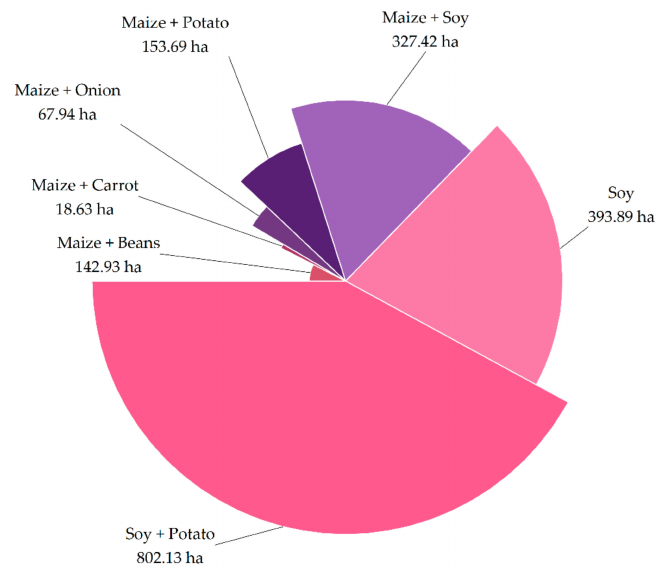
Figure 9. Crop area for each class in the 2015/2016 agricultural year.